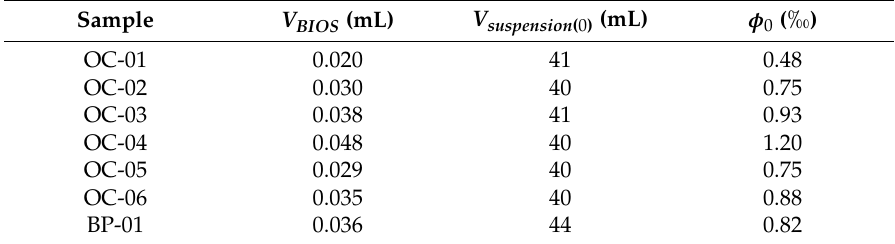
Table 4. Initial pre-cycle volumetric parameters and values.